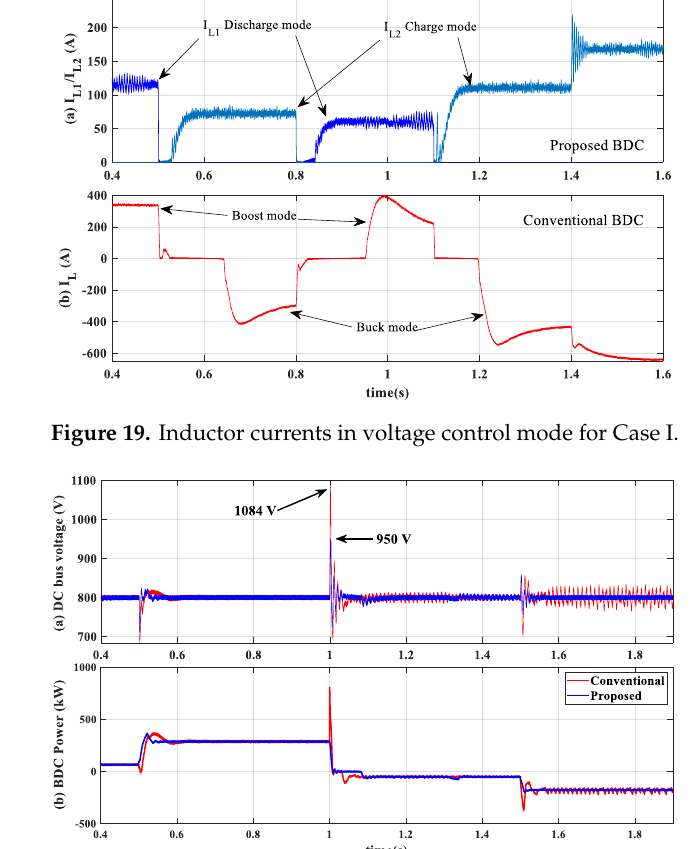
Figure 20. Converter response to pulsed DC load changes for Case I with the current controller.